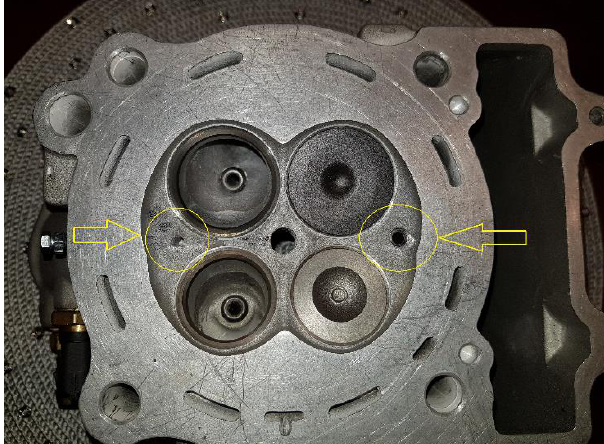
Fig. 2. Combustion engine cylinder head: view of modified head